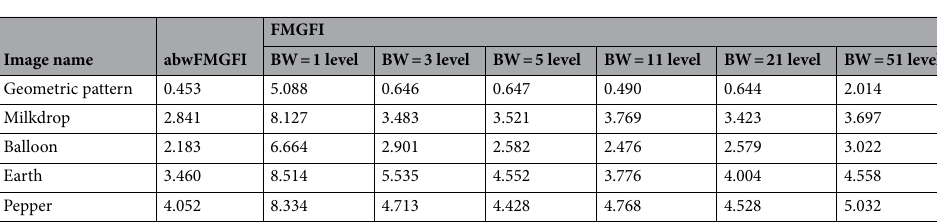
Table 5. Comparison of the RMSE values of each sample image filtered using the variable level of BW of FMGFI (against the salt-and-pepper noise).